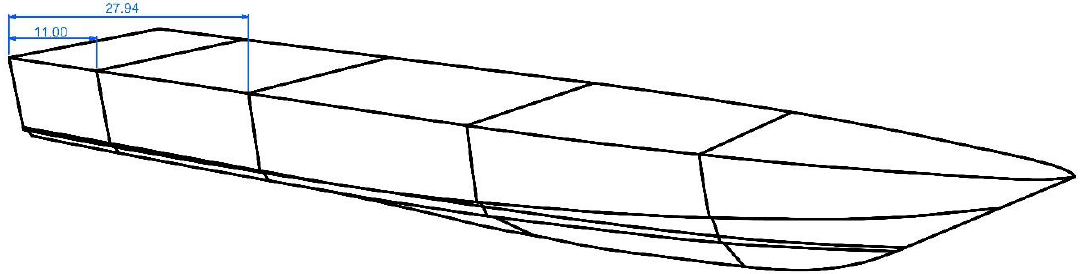
Figure 7. Hull and flooded compartment of the passenger ferry, ship scale (meters). Table 2. Main particulars of the passenger ferry.